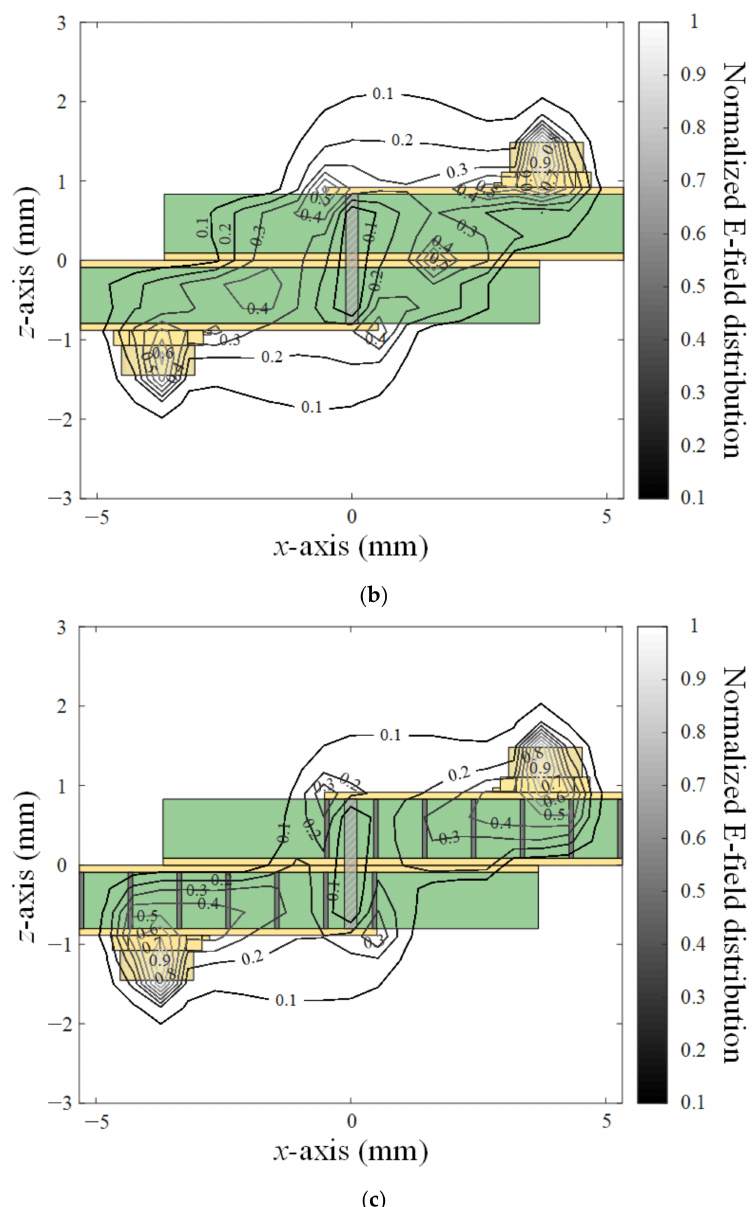
Figure 4. The normalized E-field distributions of the interface layer: ( a ) without ground; ( b ) with ground but without vias; ( c ) with ground and vias (proposed interface